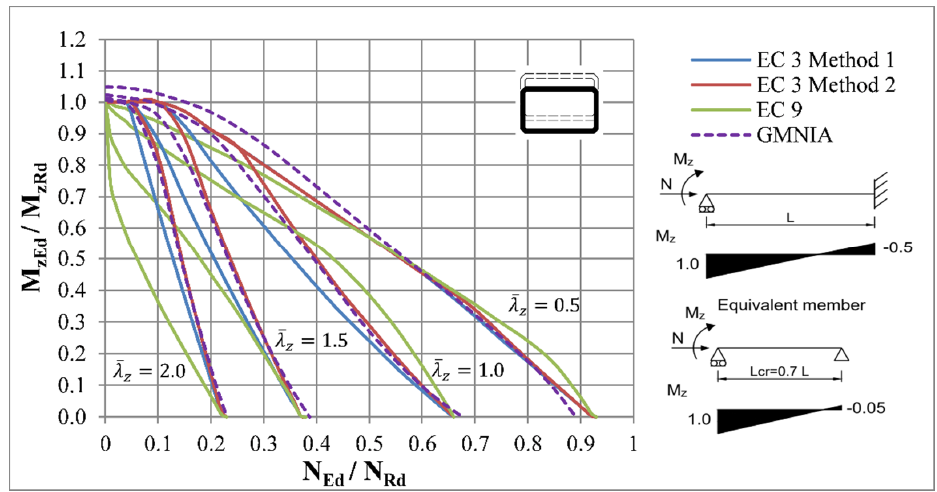
Figure 43. Interaction curves for weak axis flexural buckling of beam-columns with RHS cross- section.